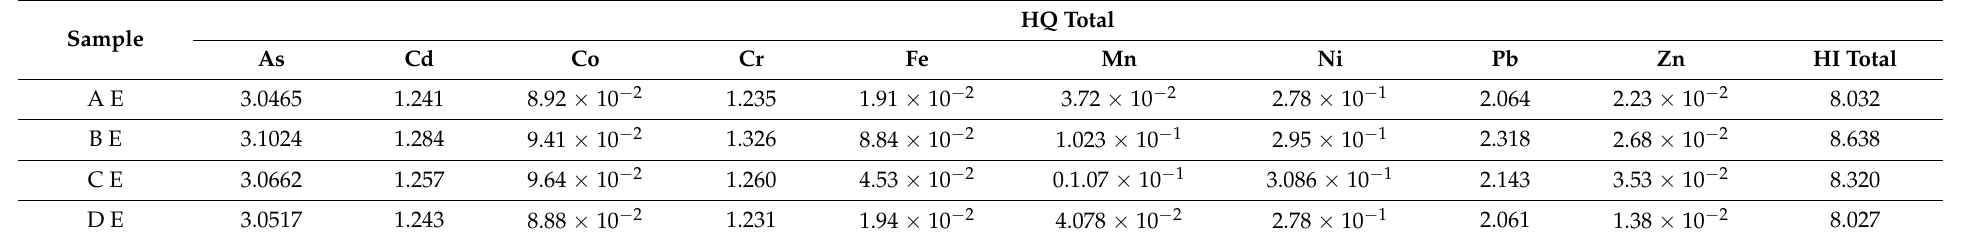
Table 2. Total hazard quotient (HQ) and hazard index (HI) for the selected heavy metals.